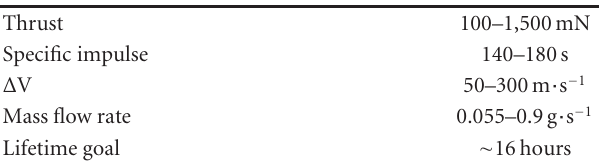
Table 5: Performance parameters of the monopropellant thruster